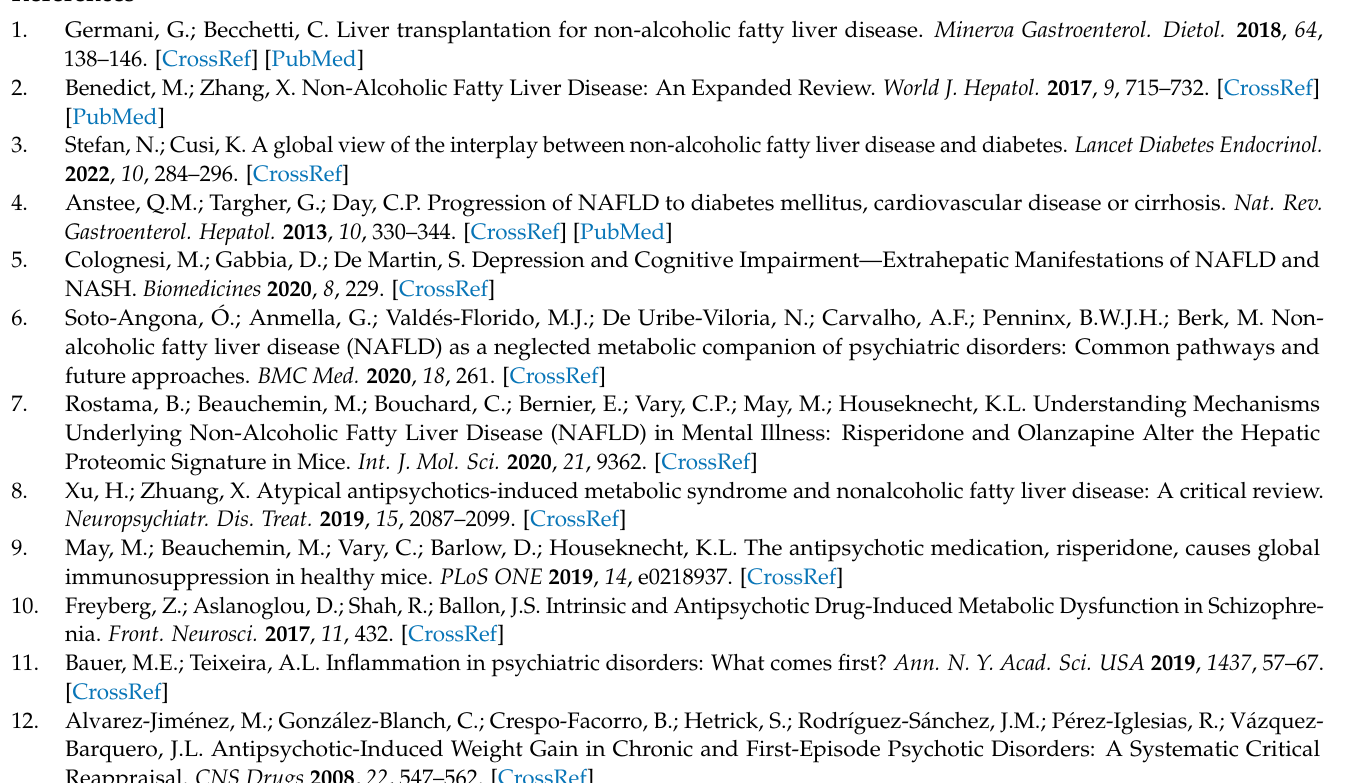
Supplementary Table S4: DE Traits from Iron-Associated